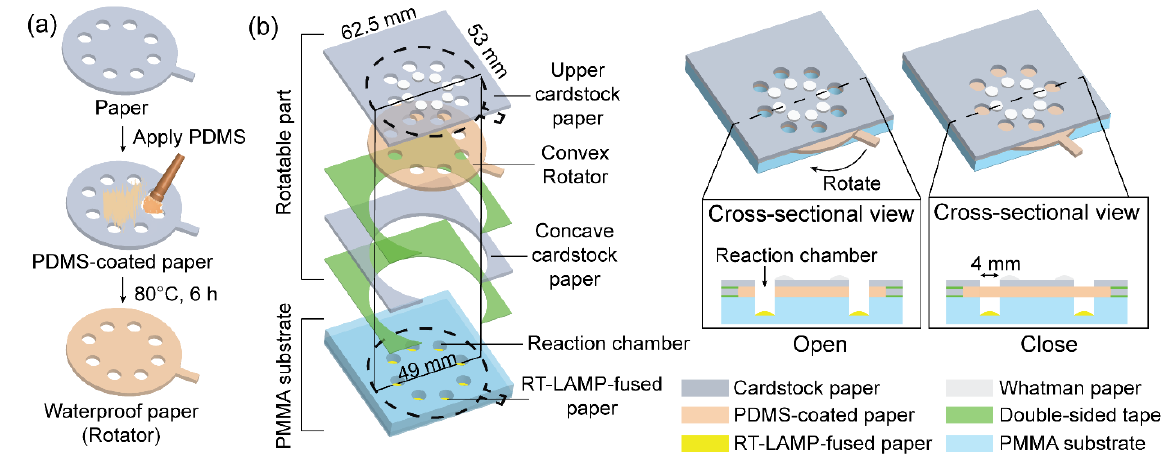
Figure 2. Schematic showing the fabrication of the rotatable paper device: ( a ) PDMS-coating process and ( b ) overall structure of rotatable paper device.